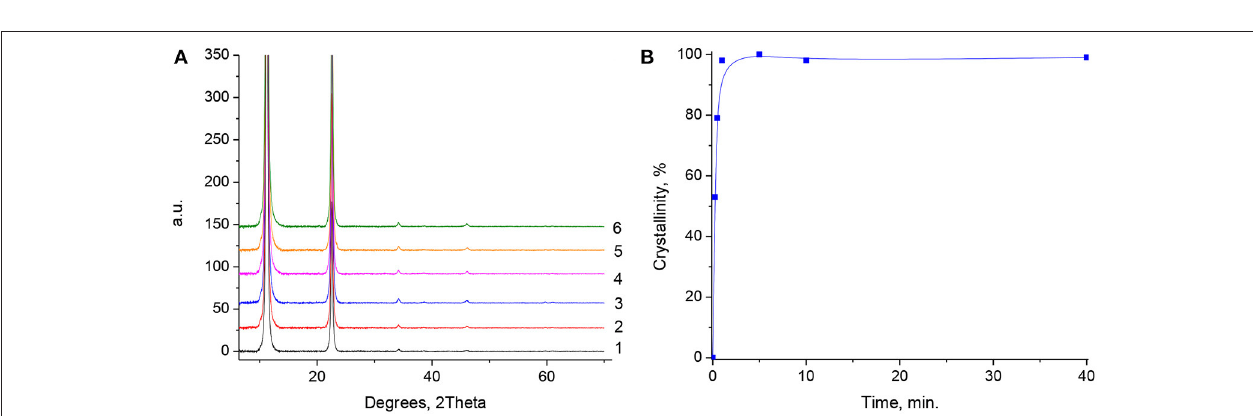
FIGURE 5 | (A) XRD patterns of reconstructed MgGa hydrotalcites at different rehydration times. 1-MgGa-3R0.25; 2-MgGa-3R0.5; 3-MgGa-3R1; 4-MgGa-3R5; 5-MgGa-3R-10; 6-MgGa-3R40. (B) The dependence of MgGa-3R crystallinity on the duration of MgGa mixed oxides rehydration.